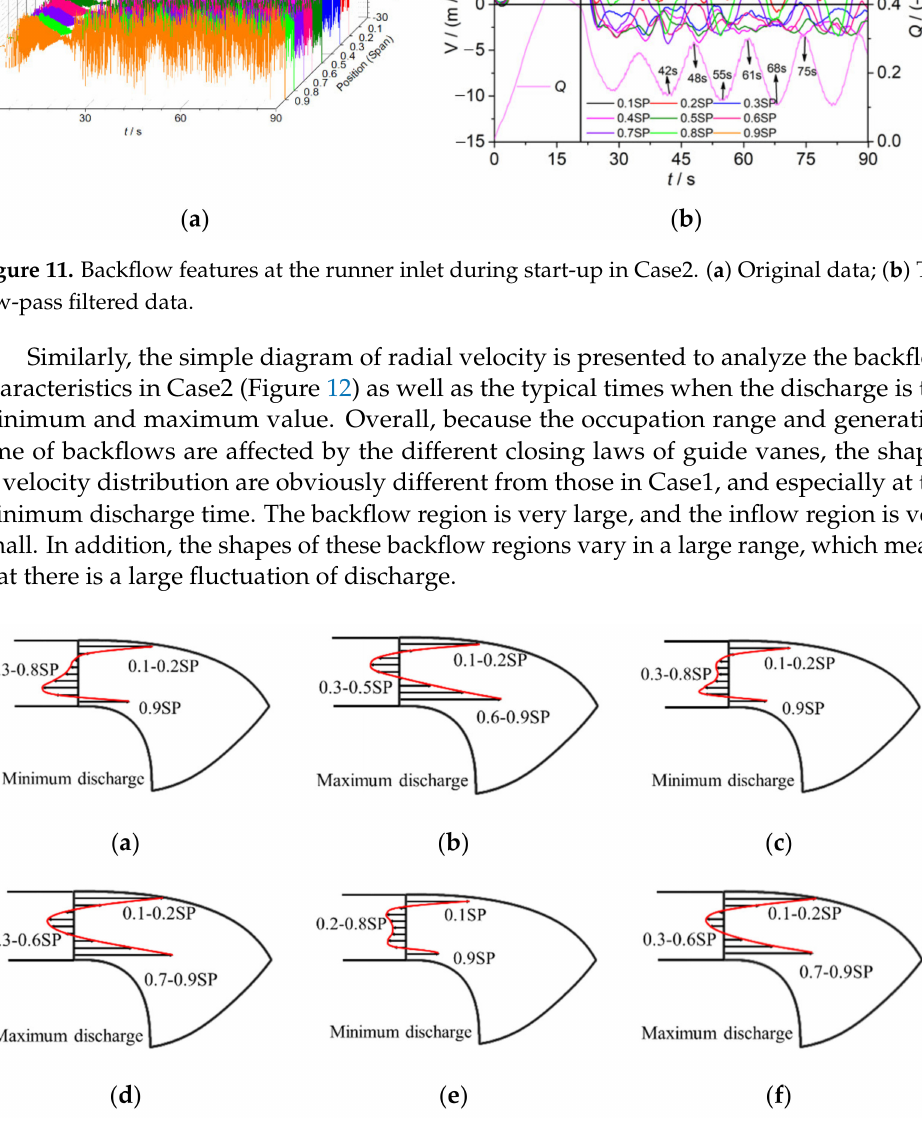
Figure 12. Radial velocity distributions at typical times in Case2. ( a ) t = 42 s; ( b ) t = 48 s; ( c ) t = 55 s; ( d ) t = 61 s; ( e ) t = 68 s; ( f ) t = 75